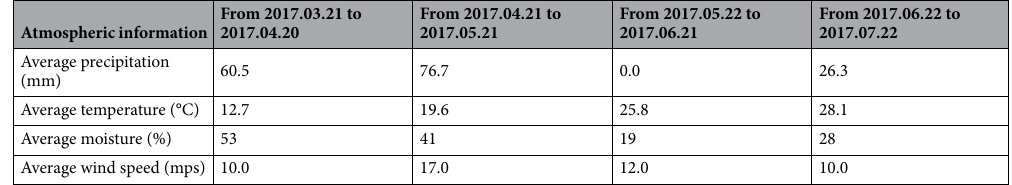
Table 1. Atmospheric information of experimental field (Iran, Tehran, Shemiranat) from meteorological